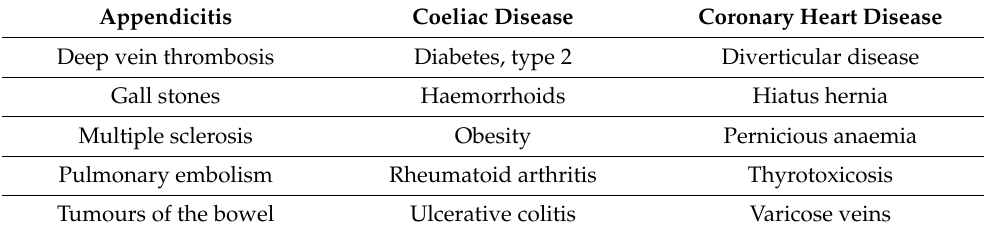
Table 1. Selected Westernized non-communicable diseases noted by Burkitt